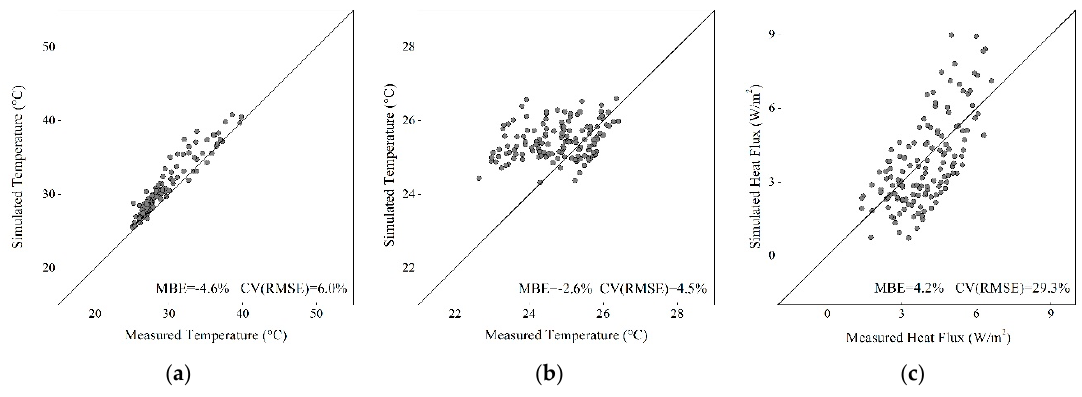
Figure 9. Comparisons of the simulated and measured values during the second measurement stage. ( a ) External surface temperatures of the green roof substrate; ( b ) internal surface temperatures of the green roof; ( c ) internal surface heat fluxes of the green roof.